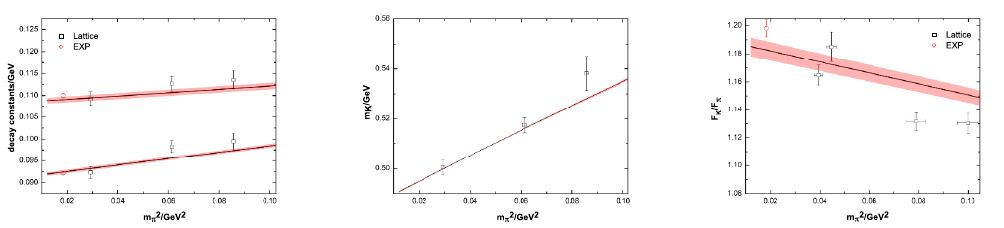
Figure 2 . The decay constants of F q and F s defined in eq. (4.17) as functions of m π . The lattice data are taken from ref. [53].